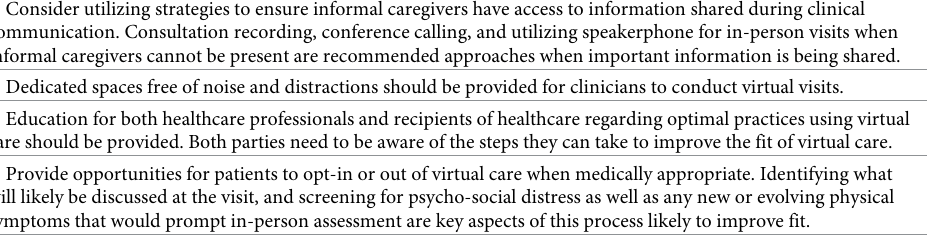
Table 5. Clinical recommendations � for virtual